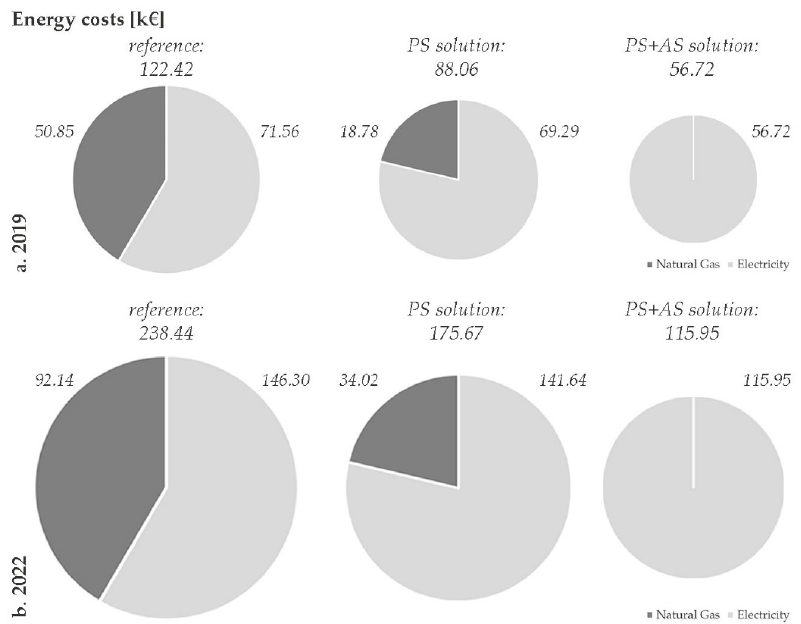
Figure 9. Comparison of the reference building, the optimal PS solution, and the PS+AS solution with respect to energy costs in ( a , b ) energy price scenarios.